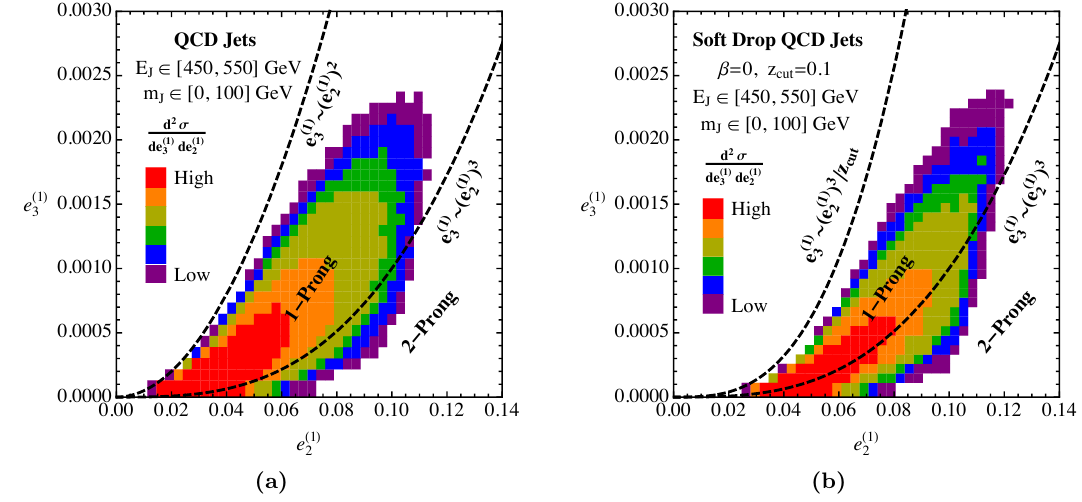
Figure 2. Illustration of the population of jets from 1 TeV e + e (cid:0) collisions in the ( e ( (cid:11) ) space plane as simulated in parton shower Monte Carlo. Here, (cid:11) = 1 and the mass of the jet is restricted as m J < 100 GeV. (a) Ungroomed jets, that extend up to e ( (cid:11) ) drop groomed jets, with z cut = 0 : 1, that extend up to e ( (cid:11) )